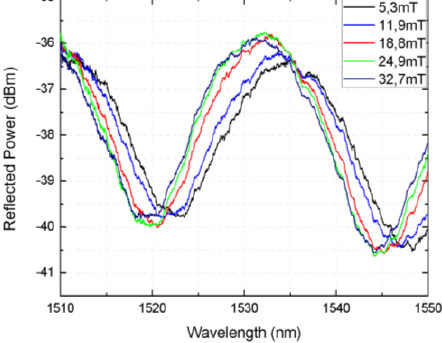
Fig. 2. Reflected spectrum at different field magnitudes.